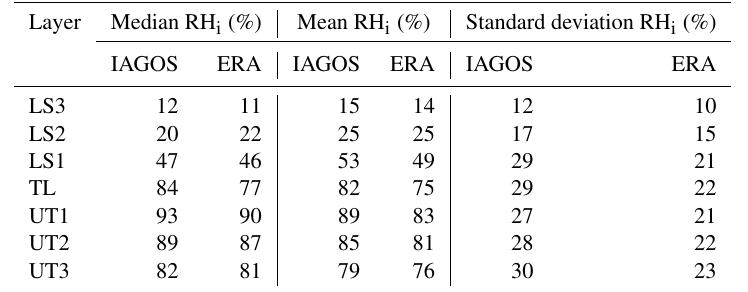
Table 4. Same as Table 2 but for RH i